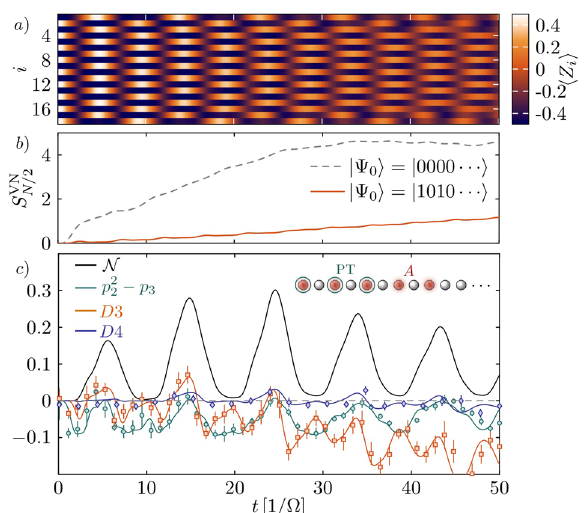
Fig. 6 Entanglement detection in quench dynamics of a kineti- cally constrained Rydberg chain (42). a Coherent oscillations of the Z i -expectation values in a quench with an 18-site Fibonacci chain from a staggered initial state: Ψ 0 j i ¼ 1010 ¼ j i . b Von Neumann entropy of half partition of the chain as a function of time if a global quench is performed on 2 different initial states. c Entanglement detection in a subsystem of 5 spins (corresponding to the red dots in the inset), with partial transpose taken with respect to the fi rst three. All plotted curves are tuned so that positive values indicate entanglement. The revivals in the negativity indicate periodic entangling and disentangling of spins within the subsystem. The goblal p 3 − PPT condition is unable to detect entanglement in the entire time window in contrast to the D 3 and D 4 conditions. The points are obtained from a classical shadow consisting of 5000 global random unitaries. Error bars are obtained by repeating the procedure 20 times and estimating the standard